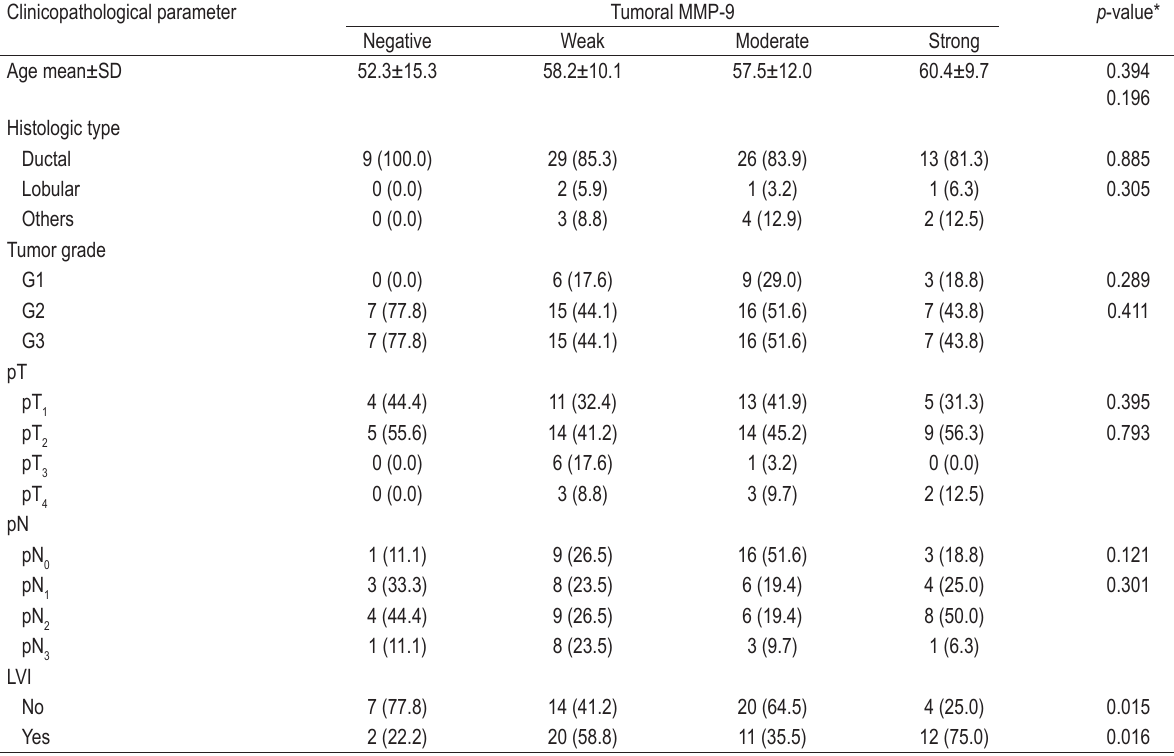
TABLE 4. Correlation of tumoral MMP-9 intensity and standard clinicopathologic parameters in breast cancer Clinicopathological parameter Tumoral MMP-9